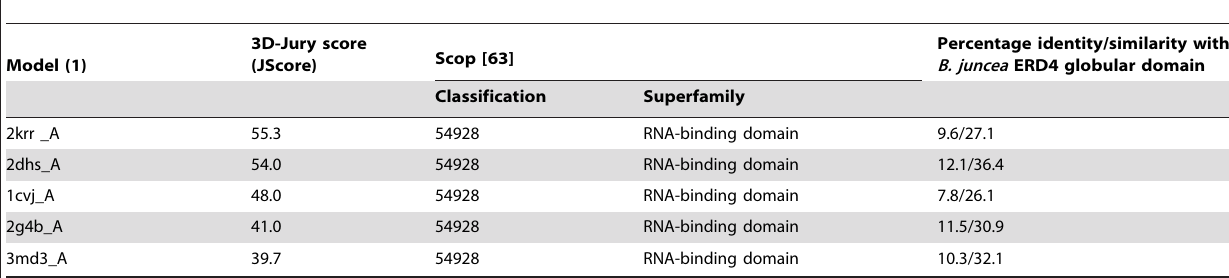
Table 2. The best five structural models predicted for the ERD4 globular domain by the fold-recognition servers and their ranking by 3D-Jury